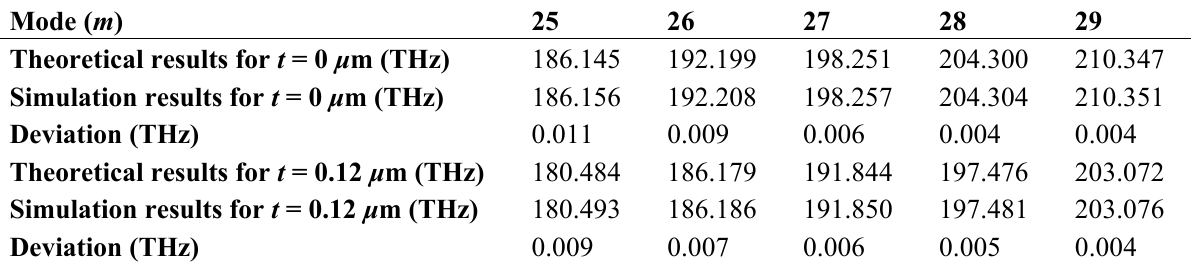
Table 1. Comparison of the analytical frequency and simulated frequency for the microring sensor and the NPM